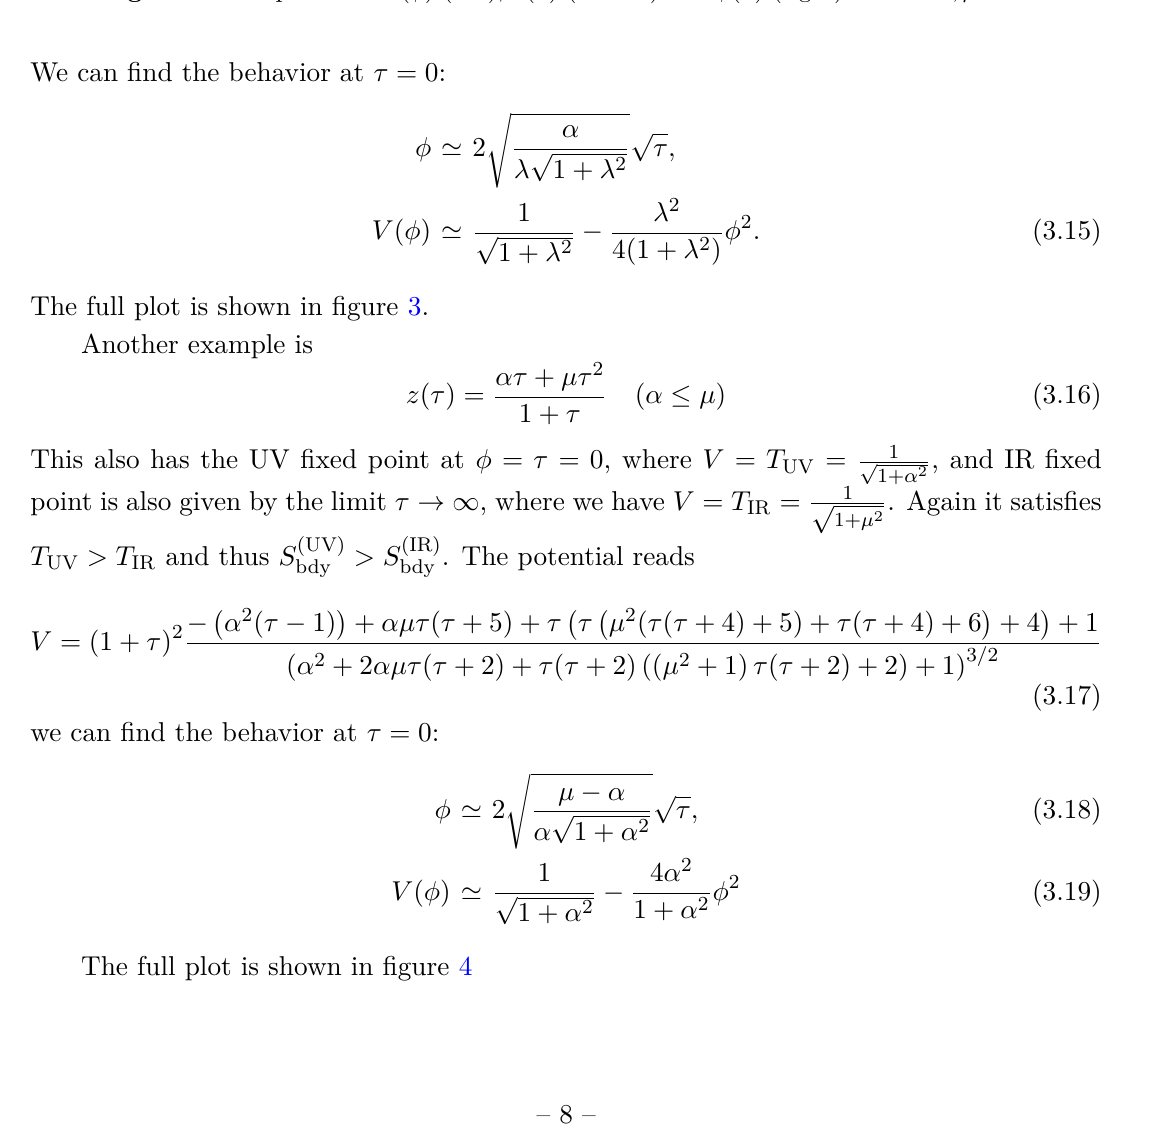
Figure 4 . The profile of V ( φ ) (left), z ( τ ) (middle) and φ ( τ ) (right) for α = 1 , µ = 2